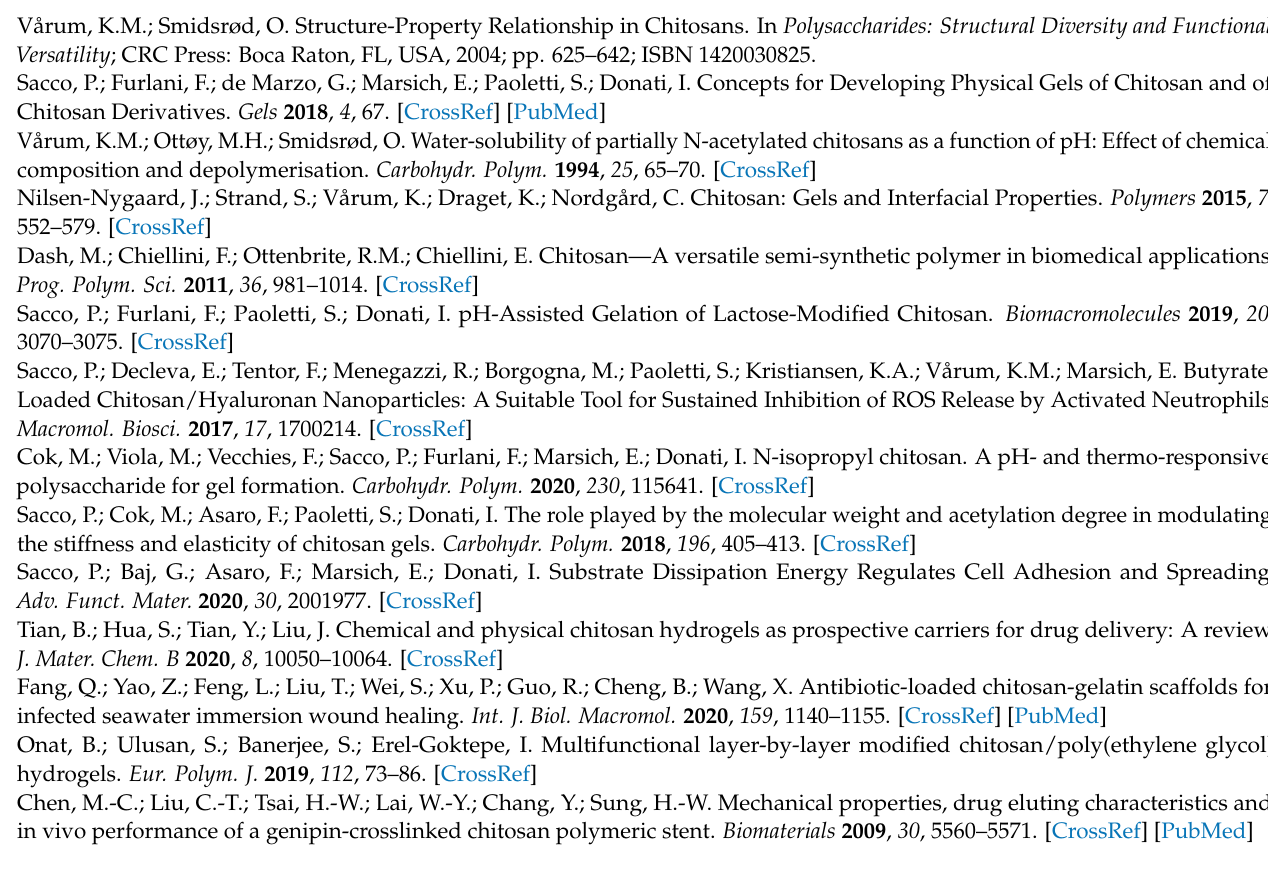
Figure S4: long stress sweep and fitting of the experimental